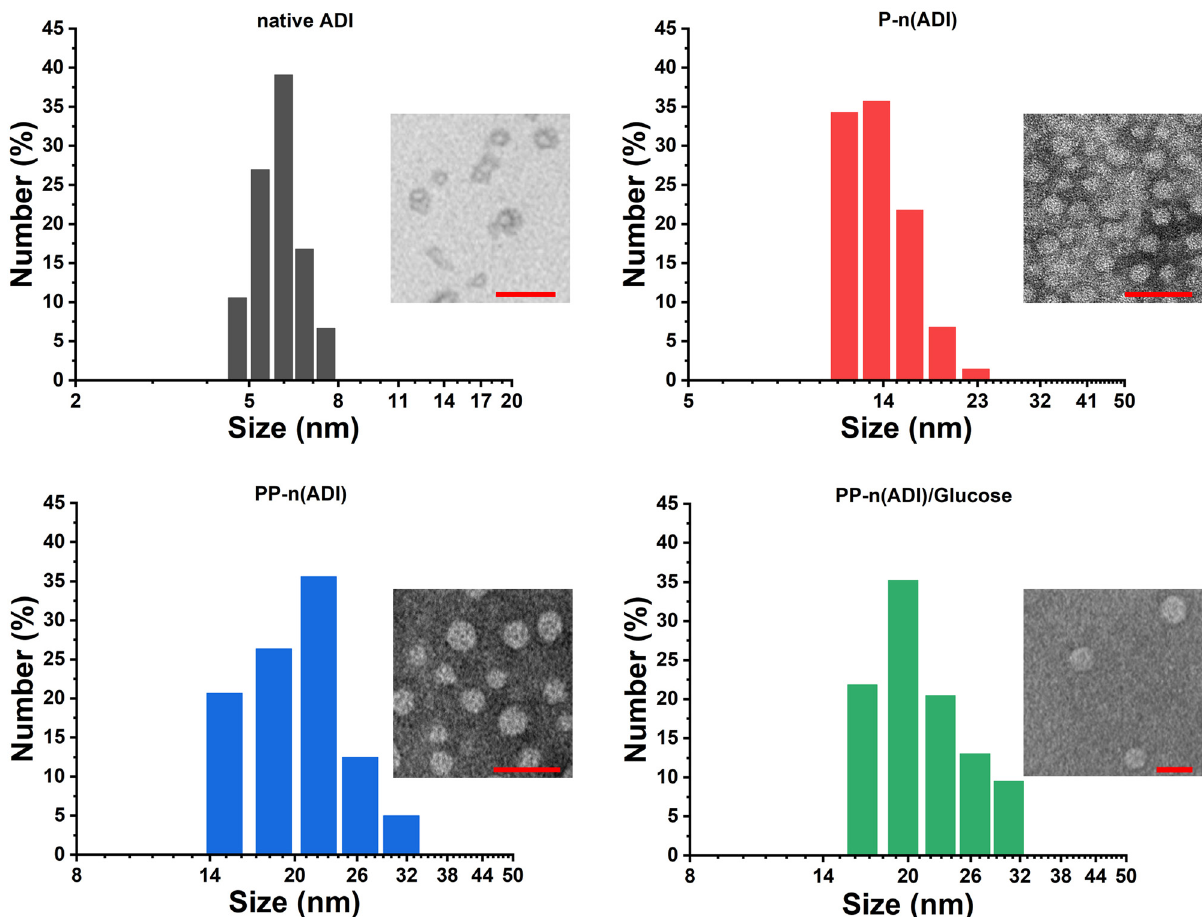
Figure 1: The size distribution of samples. The inset pictures were the corresponding TEM images. The scale bar was 50